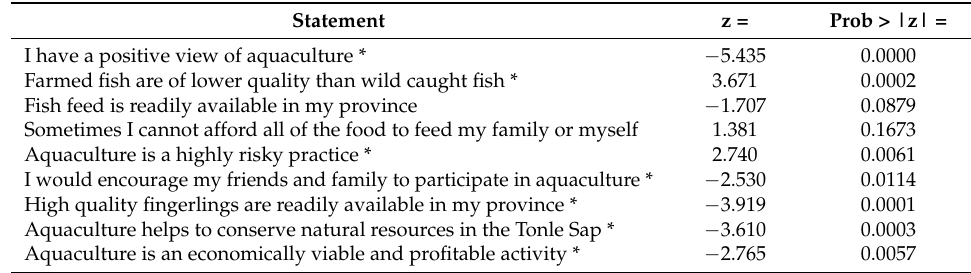
Table 8. Statistical test of differences about perceptions of small-scale aquaculture among respondents who continue to farm fish and those who do not ( n =